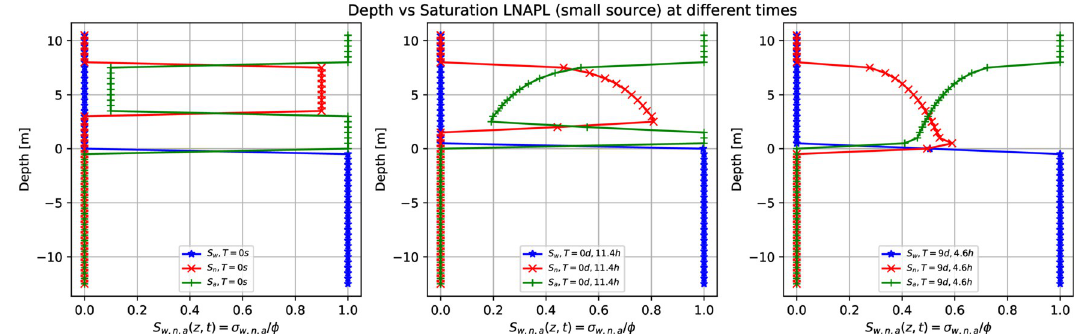
Fig 11. Depth vs. saturation of LNAPL (small source) at different times. Numerical simulation results of a depth as a function of the water saturation S w (blue points), LNAPL saturation S n (red points), and air saturation S a (green points) at various times for a small leak of LNAPL of Fig 10. Initially, at t = 0 s, there is a sharp front of contaminant saturation (red points) situated in the unsaturated zone at z = [4.0,7.0] m. Later, the contaminant moves downward, and the saturation decreases (center). On the right- hand side, the contaminant reaches the groundwater table and does not enter the saturated zone except in a small